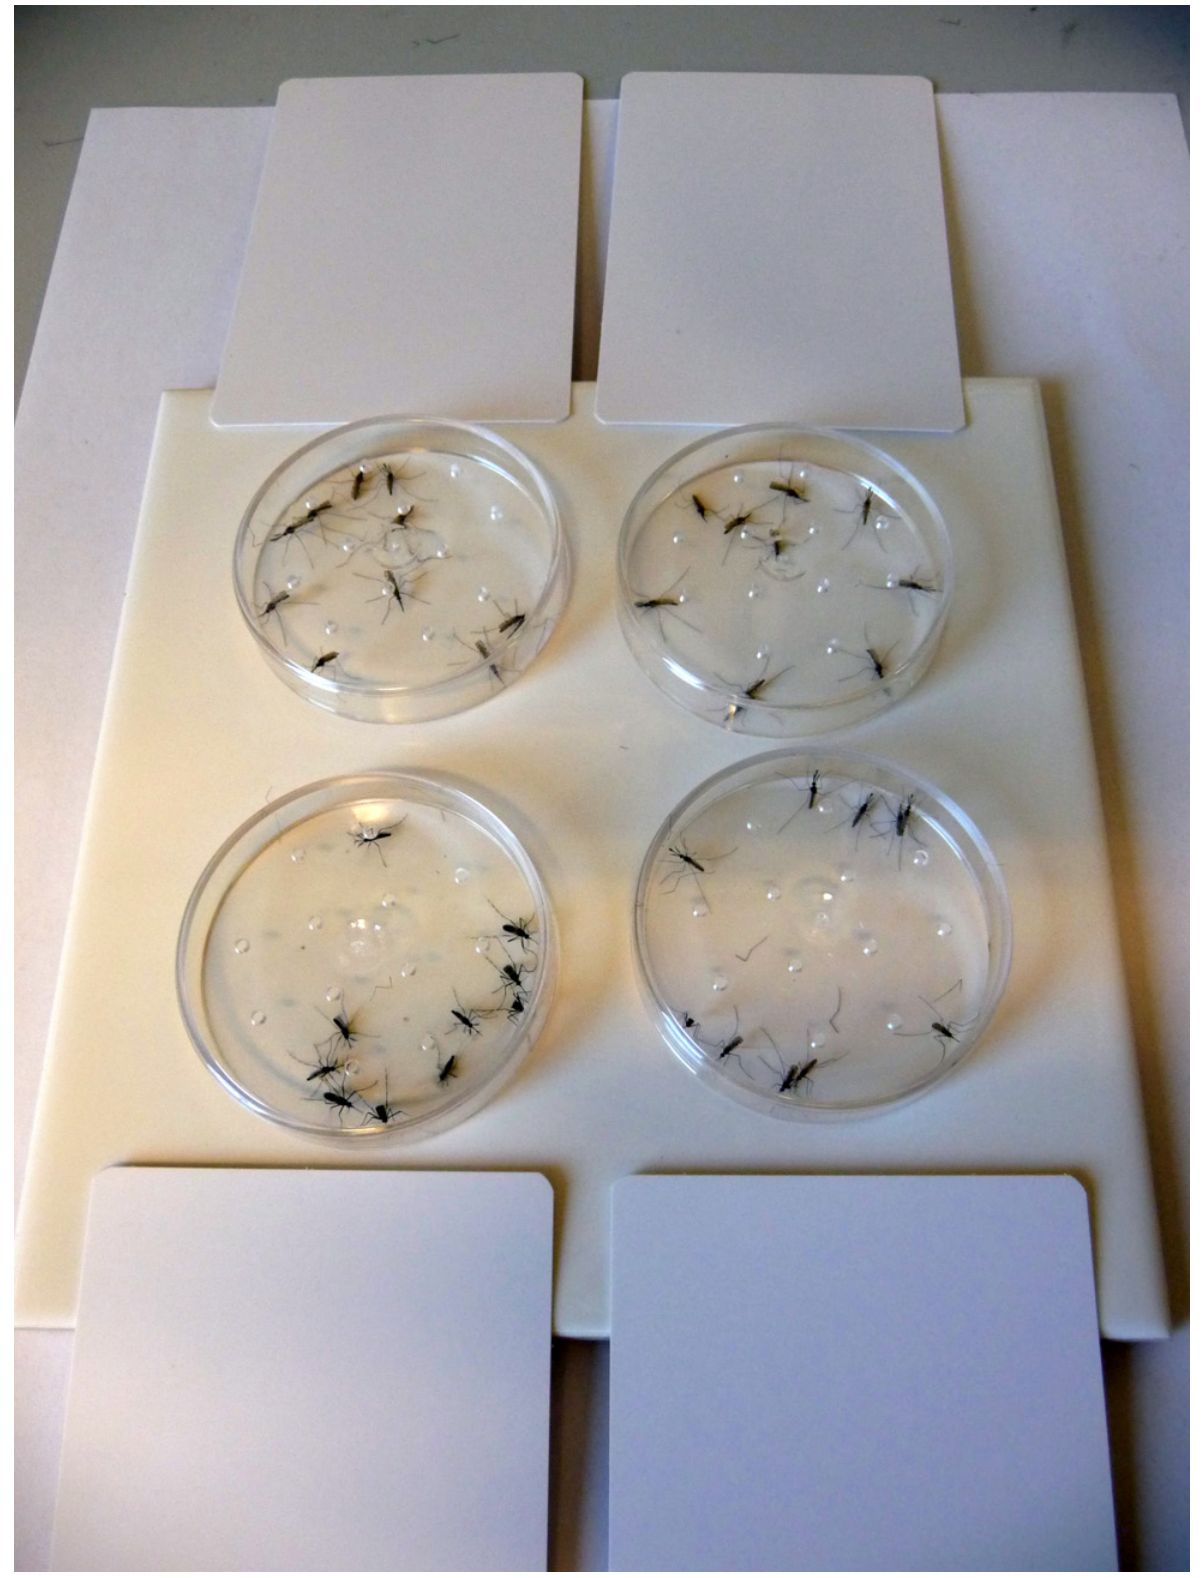
Fig 1. The arrangement of the mosquito containing Petri dishes on a glazed tile with an active ingredient-treated surface. doi:10.1371/journal.pone.0149738.g001 PLOS ONE | DOI:10.1371/journal.pone.0149738 March 1,